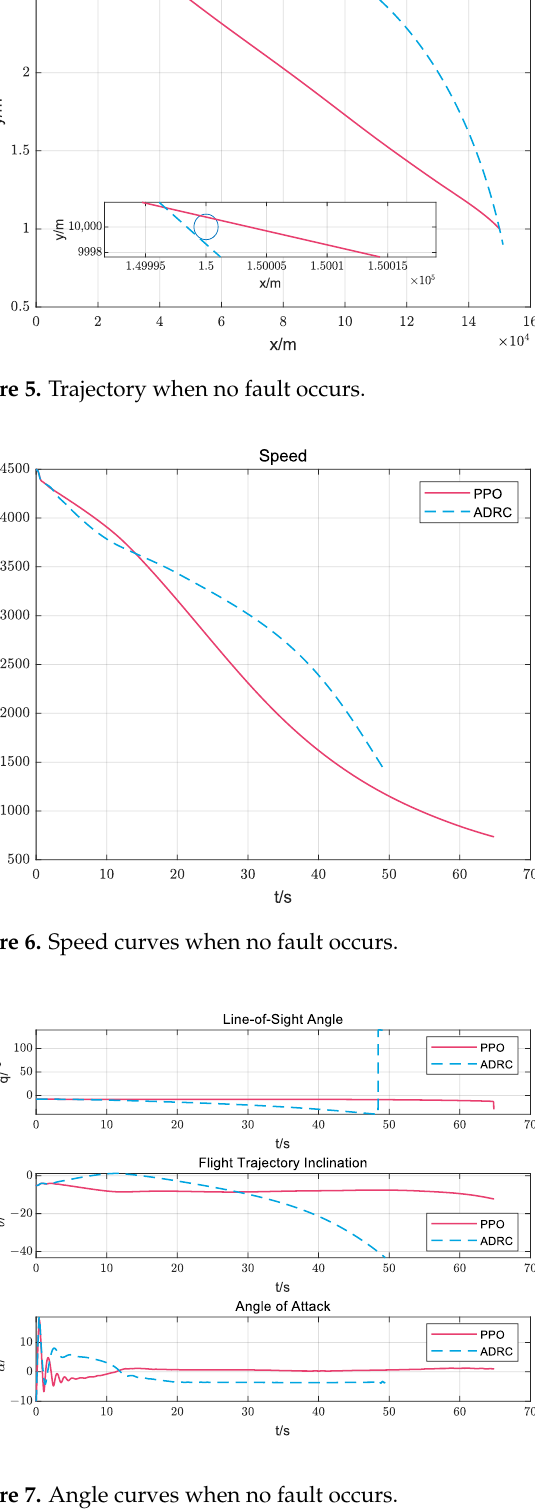
Figure 7. Angle curves when no fault